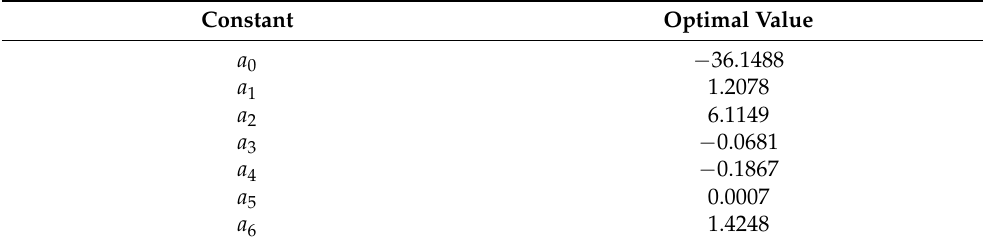
Table 4. The optimal values of permeate flux model fitting